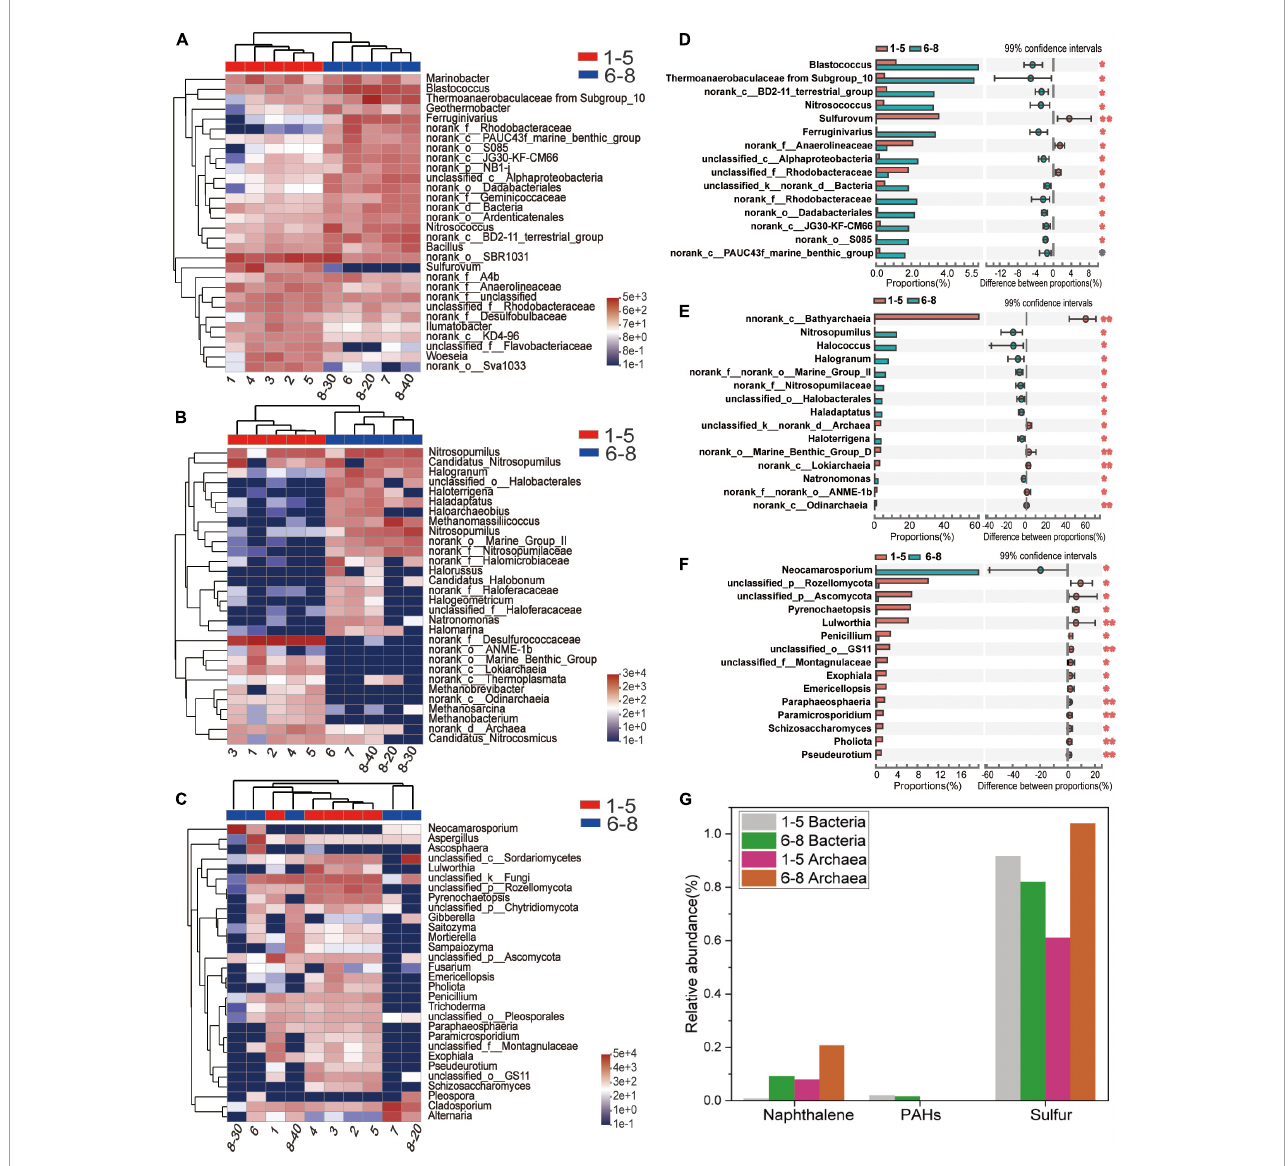
FIGURE4 (A–C) Heatmap diagrams of the dominant 30 genera; (A) bacteria, (B) archaea, (C) fungi; (D–F) comparisons of (D) bacterial, (E) archaeal and (F) fungal abundances with significant differences at the genus level. (G) Relative abundance (%) of PAHs-, Naphthalene- and sulfur-degradation genes inferred by PICRUSt 2 in the communities from coal-waste contaminated